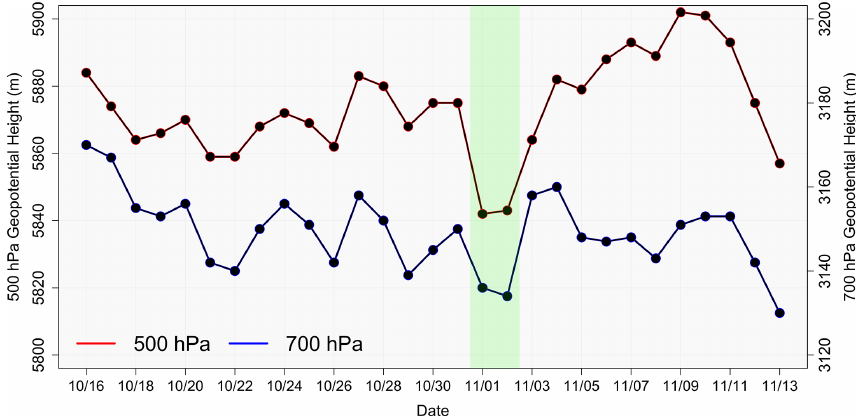
Figure 2. The 500hPa (red) and 700hPa (blue) geopotential height from the NCEP/NCAR reanalysis data.